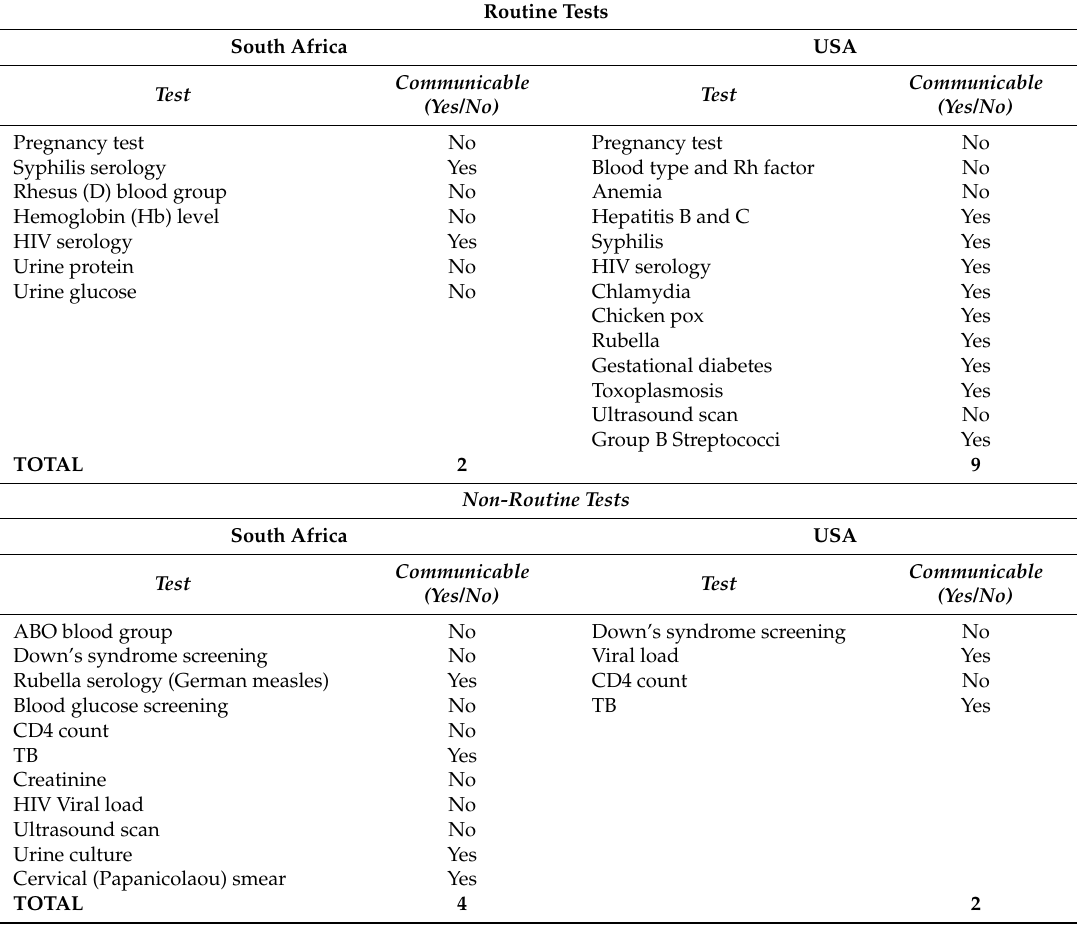
Table 2. Tests recommended for pregnant women in South Africa (SA) [28] and the USA